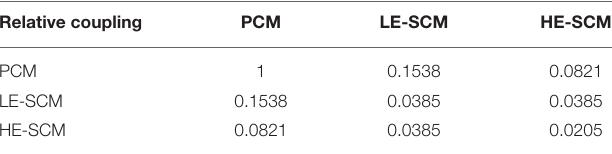
TABLE 4 | Intercellular gap junctional coupling levels in the computer model with enhanced heterocellular coupling. Relative